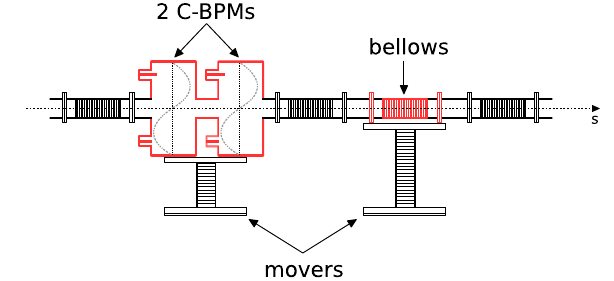
FIG. 11. Schematic of the ATF2 wakefield knobs system between BPM QD10BFF and QD10AFF.